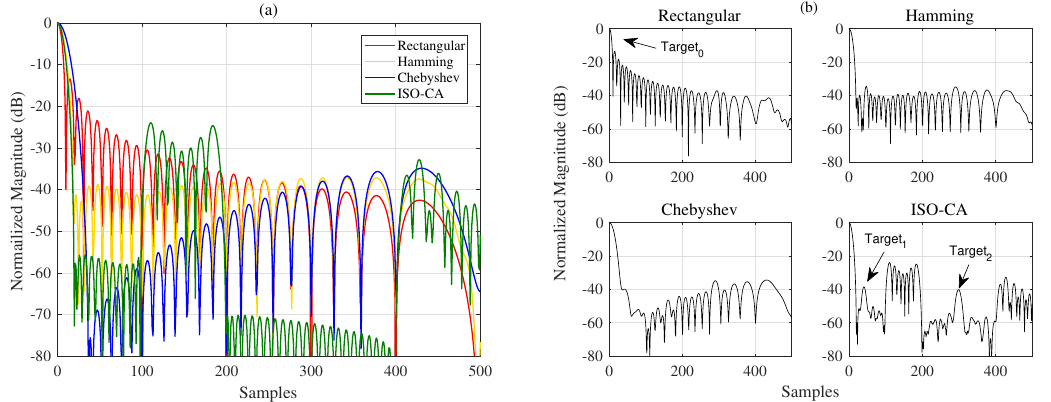
Figure 4. ( a ) Properties of different windows based on a non-rectangular input; ( b ) output of the MF for different window functions.